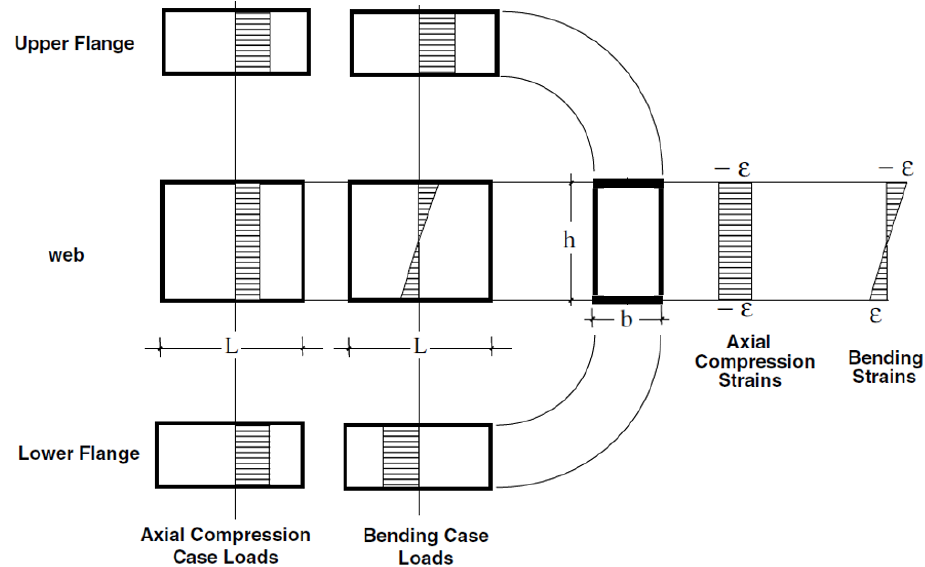
Figure 6. Distribution of strain and load per unit width in the flanges and the web of a box section subjected to axial compression or bending (modified from [86]).